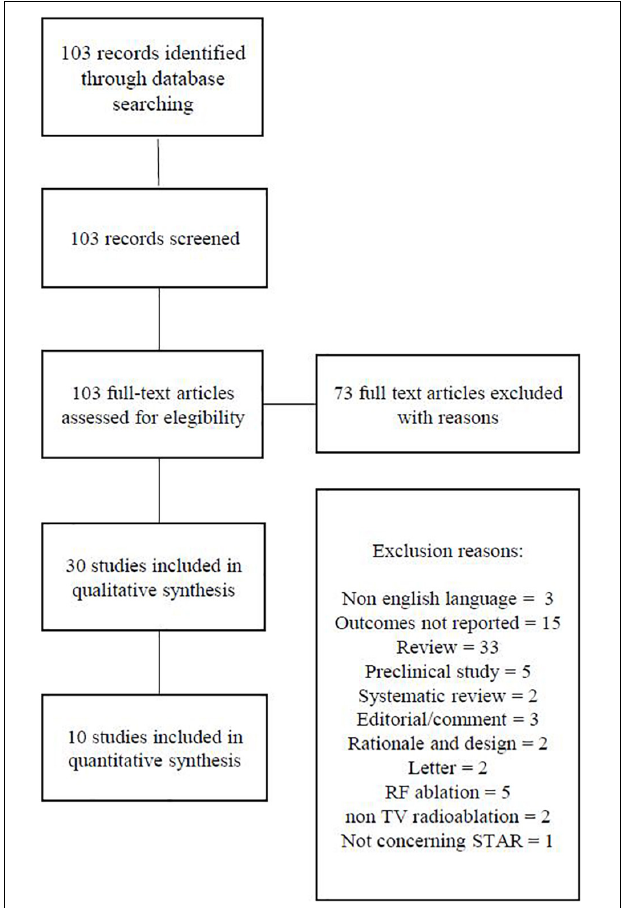
FIGURE 1 | PRISMA flow